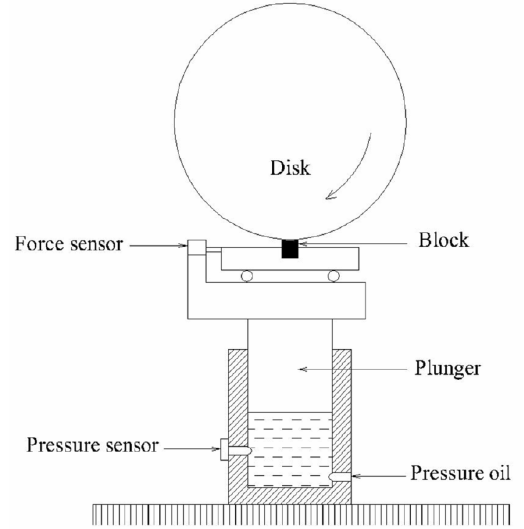
Fig. 1 Diagram of the block-on-disk-type friction testing machine.